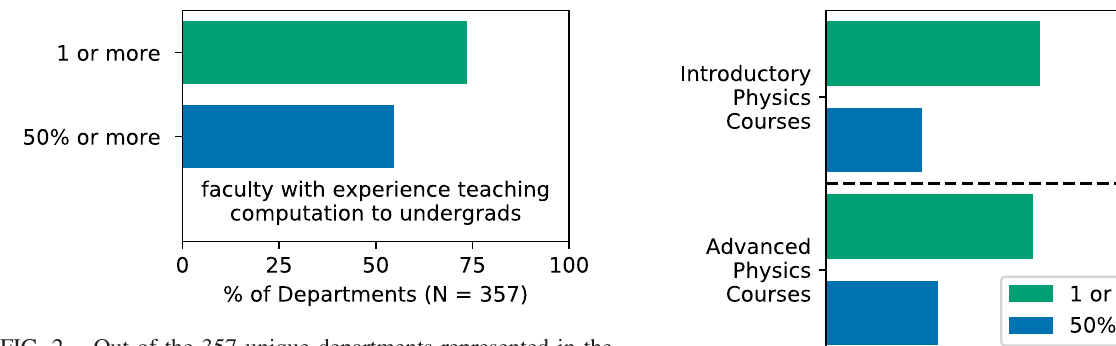
FIG. 2. Out of the 357 unique departments represented in the survey, 195 (55%) have a simple majority of their faculty reporting that they have some experience teaching computation to undergraduate physics students (blue bar). 263 (74%) depart- ments have at least one faculty member reporting this experience (green bar).